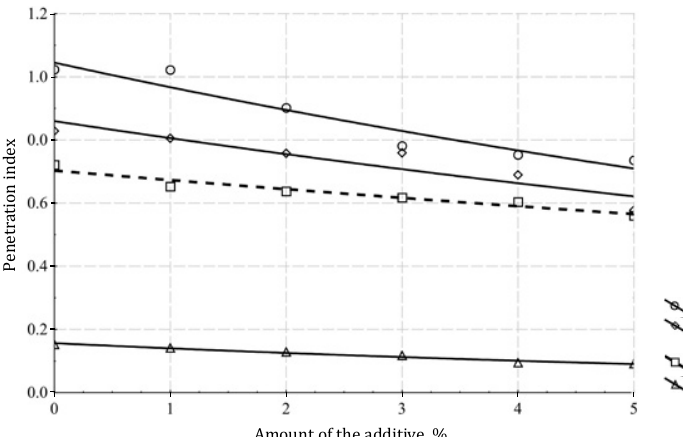
Figure 11. Penetration index based on two methods